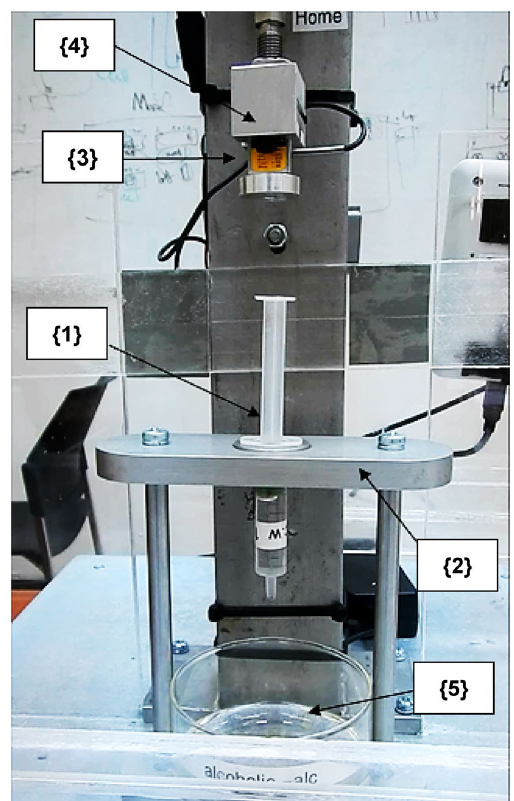
Fig. 4 General view of the used homemade experimental test-rig.